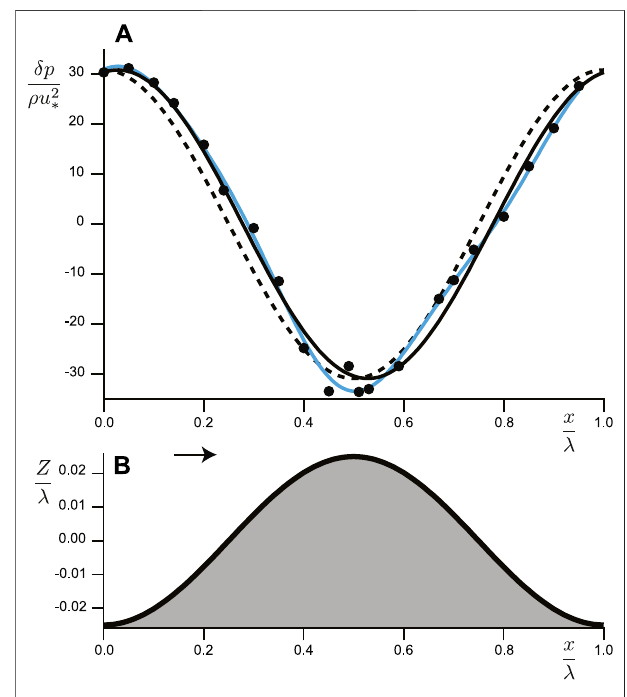
FIGURE 2 | Pressure measurements from [47]. Table 1 lists experimental conditions, and ( C , D ) inferred from ( Δ 1 , ϕ 1 ) using Eqs 7 , 8 . (A) Basal pressure variations in the fl ow direction. Filled circles are experimental data.Thebluelineisasinusoidal fi ttothirdorder( Eq.6 ).Theblacklineis the harmonic fi t k ζ Δ 1 cos ( kx − ϕ 1 ) . As the dashed line indicates, the in-phase pro fi le k ζ Δ 1 cos ( kx ) fails to capture data, con fi rming that pressure variations alongthewindlagthoseofthetopography.( B )Bedelevationpro fi lewithorigin x (cid:2) 0 at the trough and fl ow from left to right (arrow).